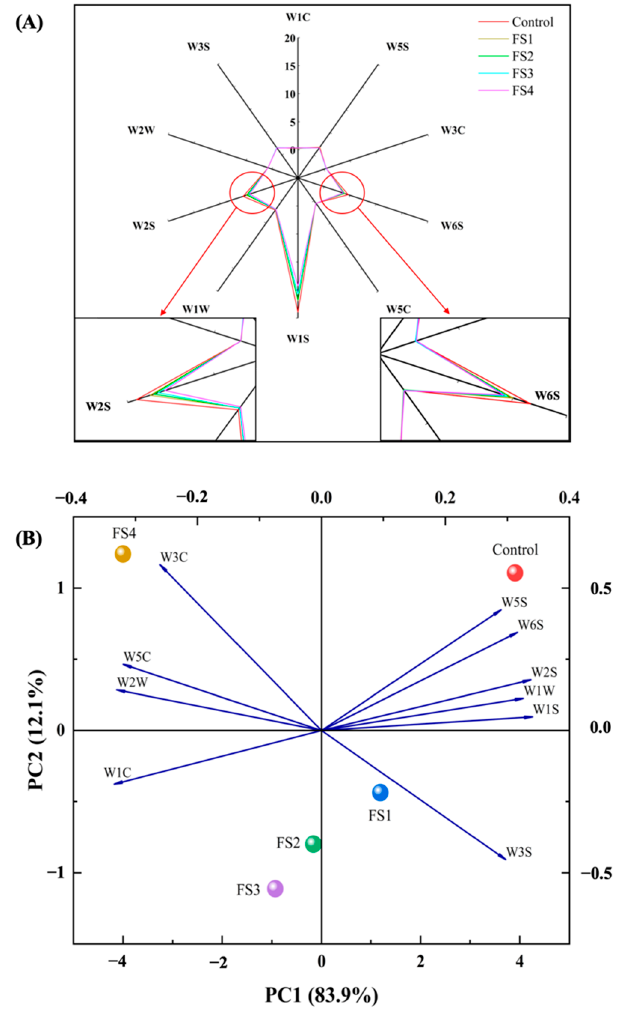
Figure 3. Radar chart of the electronic nose (E-nose) response data ( A ), principal component analysis loading plot of different treatments and sensors ( B ). Control: 100% backfat; FS1: 80% backfat and 20% CFS; FS2: 60% backfat and 40% CFS; FS3: 40% backfat and 60% CFS; FS4: 20% backfat and 80% CFS.